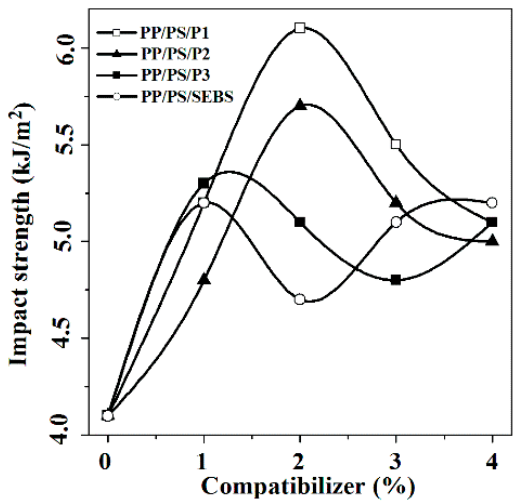
Figure 3. Impact strength of blends with varied amounts of compatibilizers.